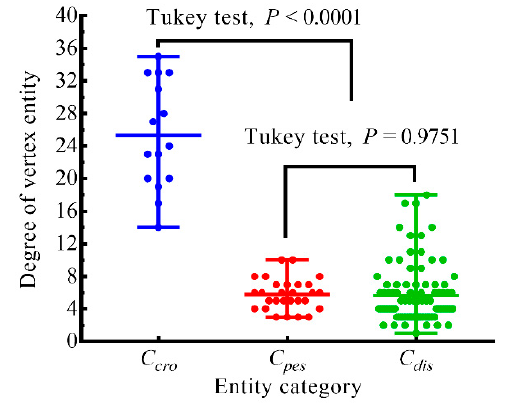
Figure 4. Comparison of the degree of vertex entity ( Dv ).